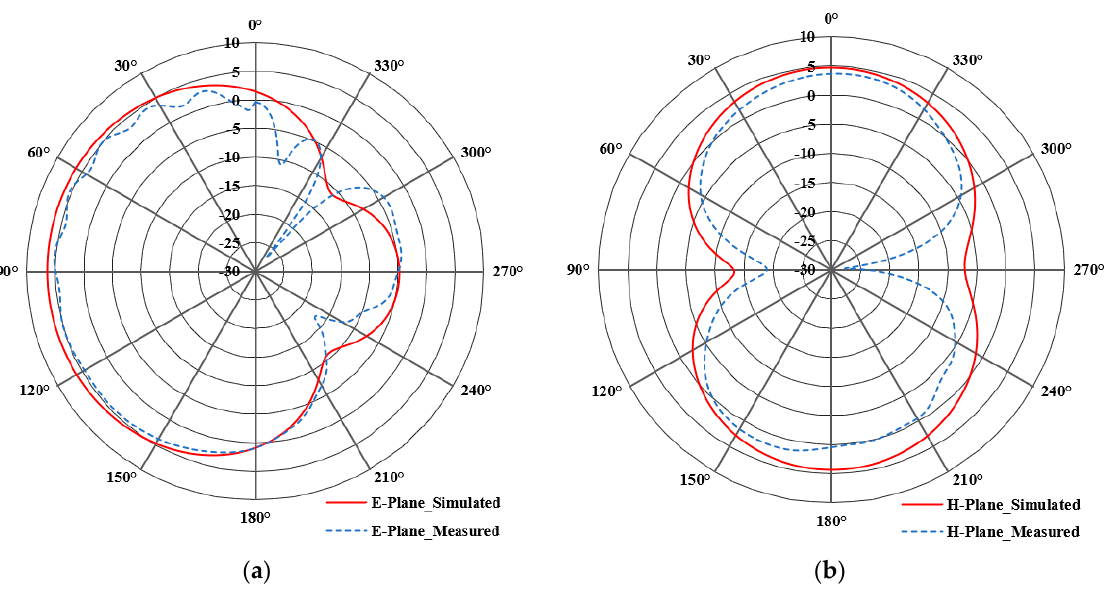
Figure 8. Simulated and measured radiation pattern of the proposed antenna at 3.5 GHz: ( a ) E − Plane, ( b ) H − Plane.